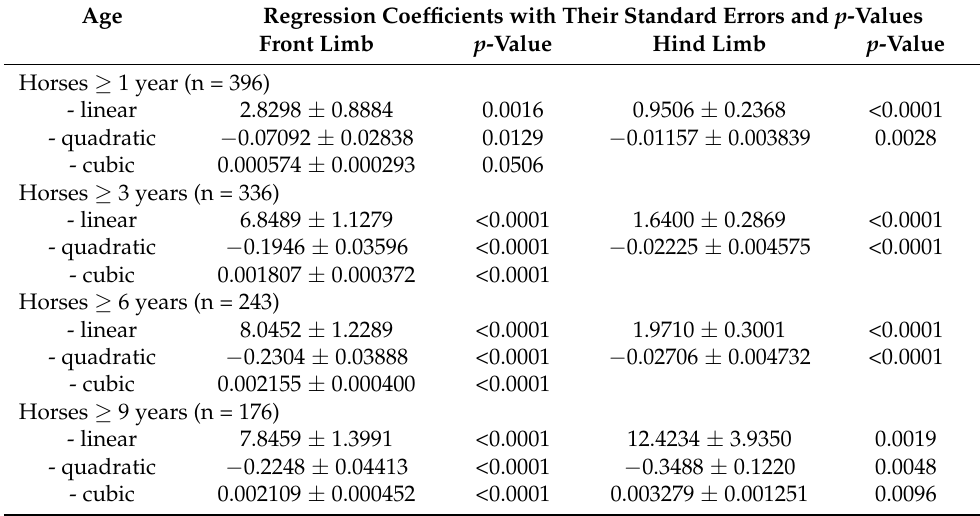
Table 8. Estimates of linear, quadratic and cubic regression coefficients with their standard errors (SE) and p -values of the cannon bone circumference at the front left limb and right hind limb on CPL-scores for Rhenish German draught horses and with ages greater than 1, 3, 6, and 9 years using a normal distribution